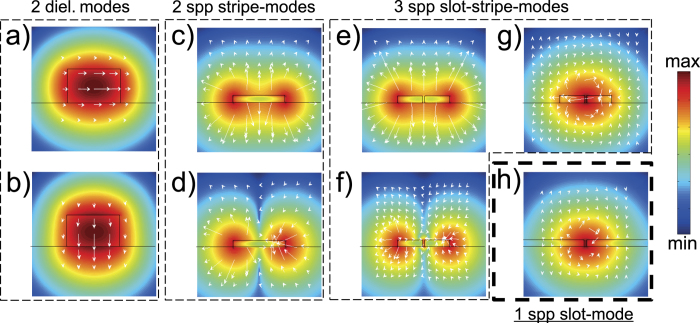
Waveguide modes.(a–h) Logarithmic intensity distributions and polarizations indicated by white arrows. (a) The TE mode in the dielectric waveguide, (b) the corresponding TM mode, (c) the fundamental and (d) 2nd SPP mode of a simple stripe waveguide, (e,f) the corresponding modes of a slotted stripe waveguide, (g) the 3rd mode for this cross-section, i.e., the slot-stripe mode and (h) the sole and highly localized plasmonic slot-mode featuring a polarization allowing for excitation by the TE mode of the dielectric waveguide. All subfigures have separate color-gradients.